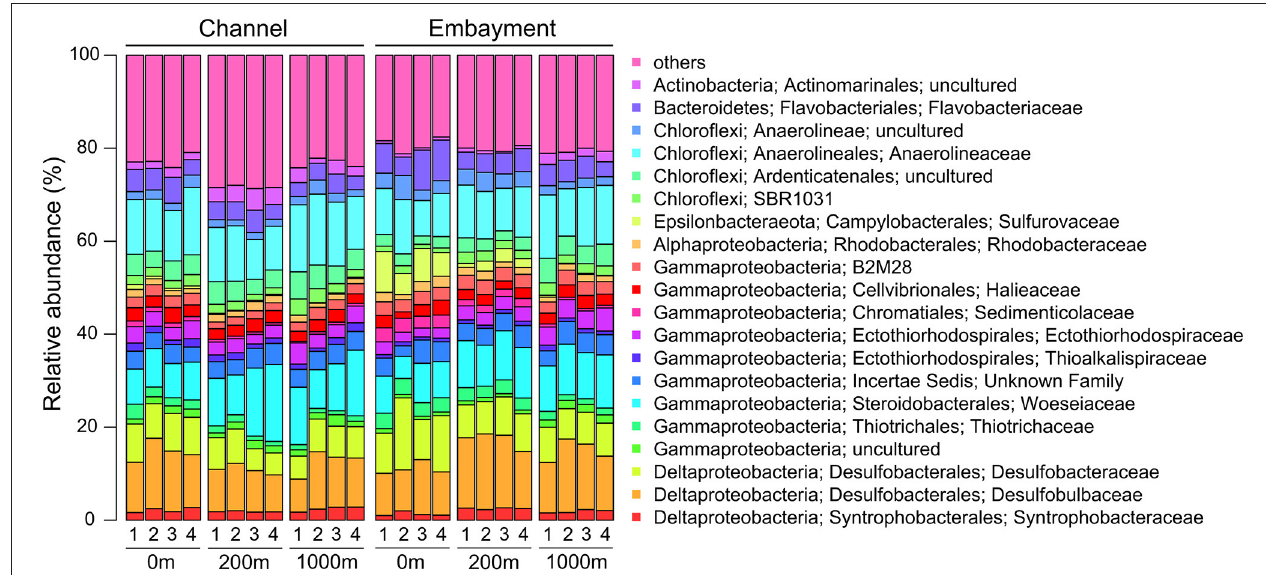
Table 2 ). In contrast, sediments sampled in channels did not differ in diversity with distance from storm drains ( Figure 3 and Table 2 ). Sediments for microbial analyses were collected